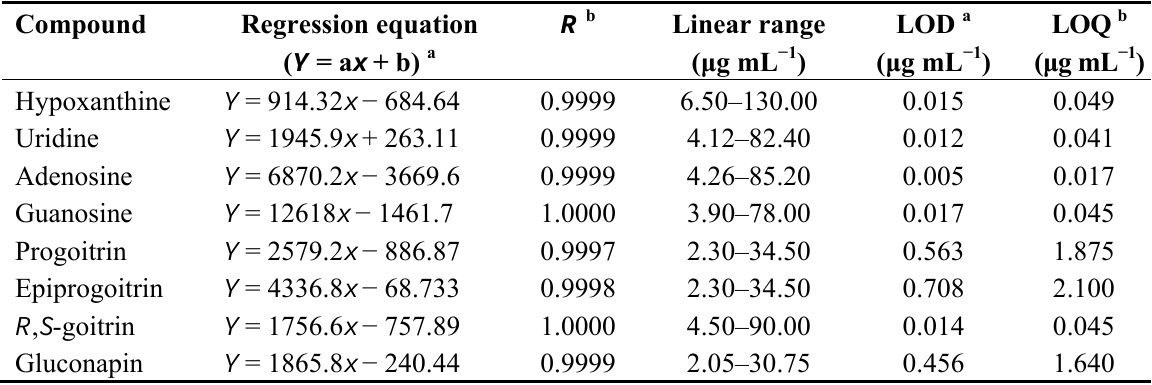
Table 1. Regression data, limits of detection (LODs), and limits of quantification (LOQs) for the eight bioactive